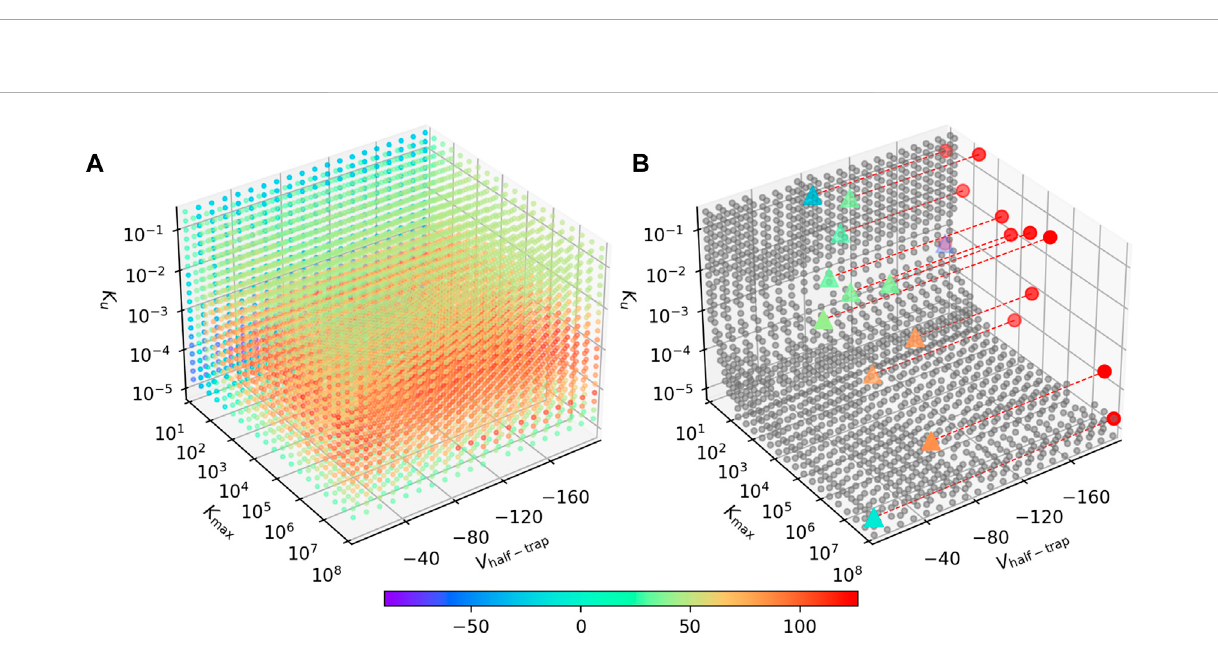
FIGURE 7 The AP-SD model is most likely to return higher APD 90 s than the AP-CS model. (A) The APD 90 differences for combinations of V half − trap , K max and K u parameters.ThecolorofthemarkersindicatethesignedRMSDofeachvirtualdrugintheparameterspace. (B) Thegreycirclesareparametervaluecombination where the signed RMSD is between − 30 and 30 ms. The triangles are the synthetic drugs taken from Li et al. (2017), color coded with their signed RMSD value. These triangles are projected to the K max — K u plane as red circles for better visualisation. Some data points are missing due to numerical issues with these parameter